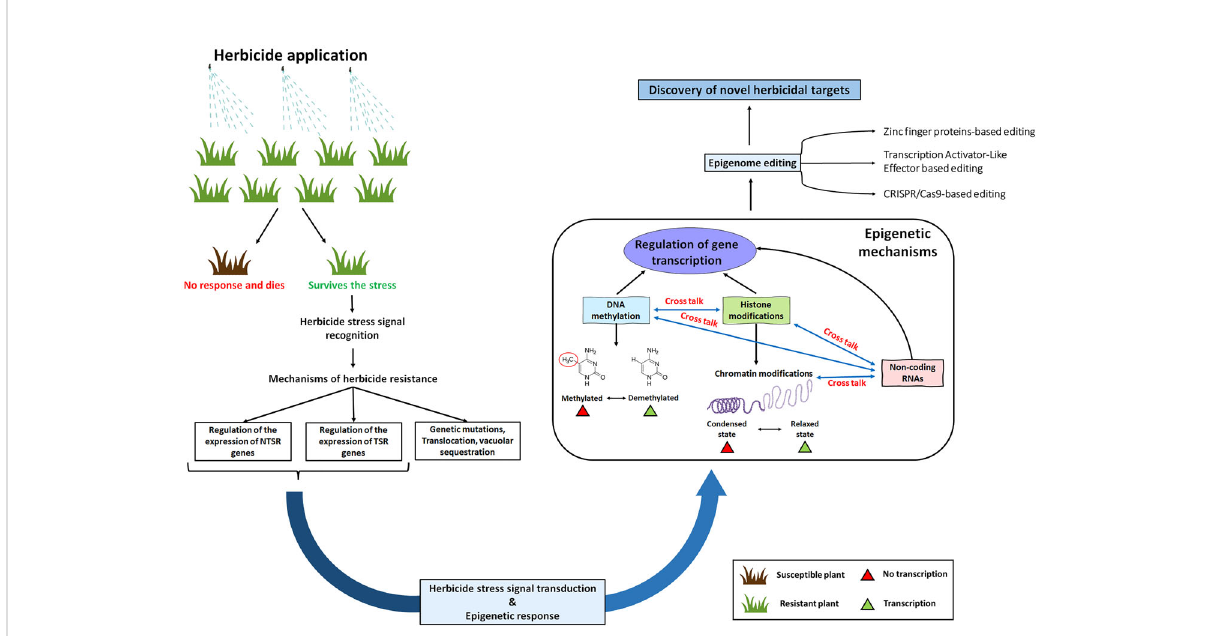
FIGURE 1 A schematic diagram showing the scope of epigenetic mechanisms in herbicide resistance. Plants can survive the herbicide stresses either by target site mechanisms (TSRs) or by non-target site mechanisms (NTSRs). Following the herbicide stress signal recognition and signal transduction, there might be an epigenetic response which might cause modi fi cations in the DNA and histone methylation enzymes. Additionally, these modi fi cations might also occur in the epigenetic regulators such as small RNAs and histone variants. Finally, these epigenetic mechanisms will regulate the expression of TSR genes (such as acetolactate synthase or acetyl CoA Carboxylase ) and NTSR genes (such as cytochrome P450s , Glutathione S-transferases and ABC transporters